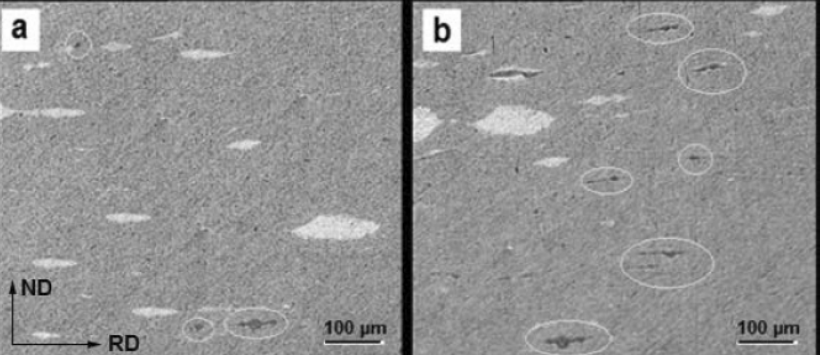
Fig. 6. The light micrographs of retained fragment of the initial powder layer after seven cycles of the ARB (a) microparticles and (b) nanoparticles.